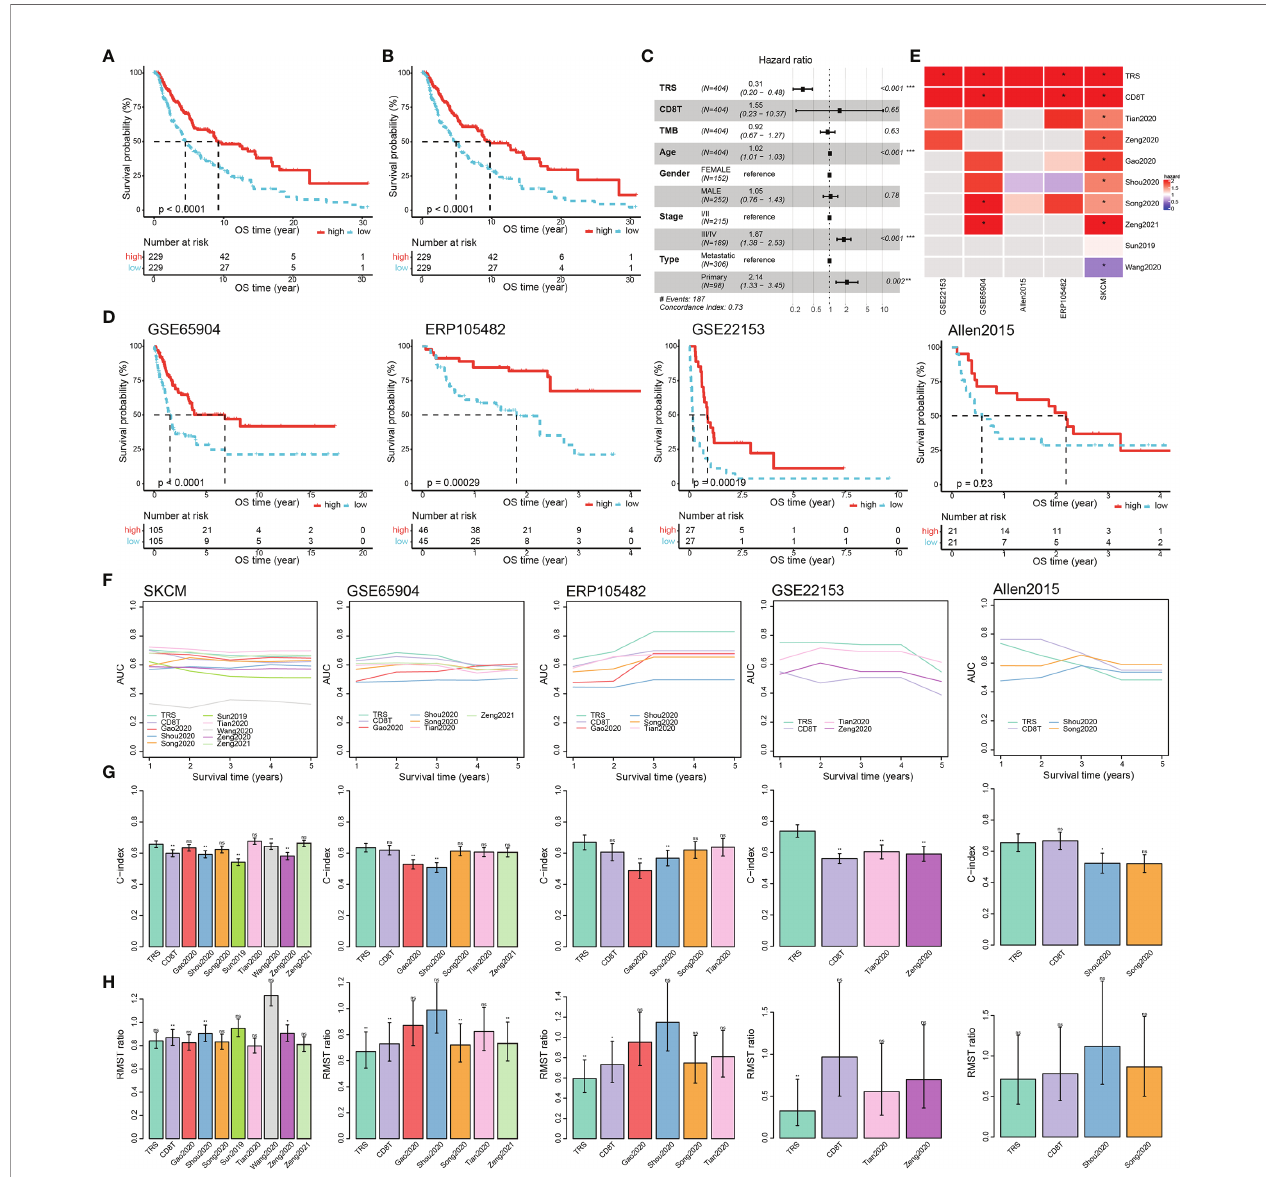
FIGURE 5 | Prognostic assessment of the TRS in melanoma. (A) Kaplan-Meier survival curves showing signi fi cant differences of survival probabilities for patients strati fi cation based on the median TRS score in the TCGA-SKCM cohort. (B) Kaplan-Meier survival curve analysis for the re fi ned TRS. (C) Forest plot showing independent prognostic value of the TRS score adjusting for in fi ltration levels of CD8+ T cells and clinical characteristics in the TCGA-SKCM cohort. (D) Kaplan-Meier survival curves showing signi fi cant association of the TRS with overall survival in melanoma patients obtained from GSE65904, ERP105482, GSE22153 and Allen2015. (E-H) Comparison of prognostic performance of the TRS with CD8+ T cell in fi ltration and 8 published prognostic-related signatures in melanoma in terms of signi fi cance of patient strati fi cation (E) , time-dependent AUC (F) , C-index (G) and restricted mean survival time (RMST) ratio between high-risk and low-risk groups (H) . In order to keep consistency of the scores in prognosis prediction, we calculated the negative value of TRS scores and CD8+ T cell in fi ltration levels as the corresponding risk scores. Colors in (E) denoted hazard ratios of the signatures in univariate Cox proportional hazard regression analysis, and * indicated signi fi cant strati fi cation of melanoma patients in terms of survival probabilities based on the corresponding signatures. Comparisons of C-index between the TRS and the other signatures were performed using the compareC package (G) . ns denoted non-signi fi cant, * denoted p <0.05, ** denoted p <0.01, *** denotes p <